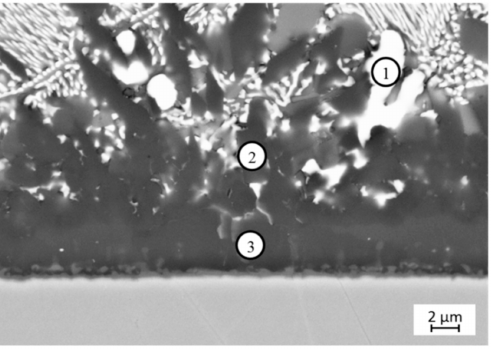
Figure 4. Braze seam of area marked in Figure 3, 1: Al-Ag-rich solid solution, 2: Fe-containing Al-rich phase (probably Al13Fe4), 3: intermetallic phase seam of Al-Fe type with contents of Cr and Ni